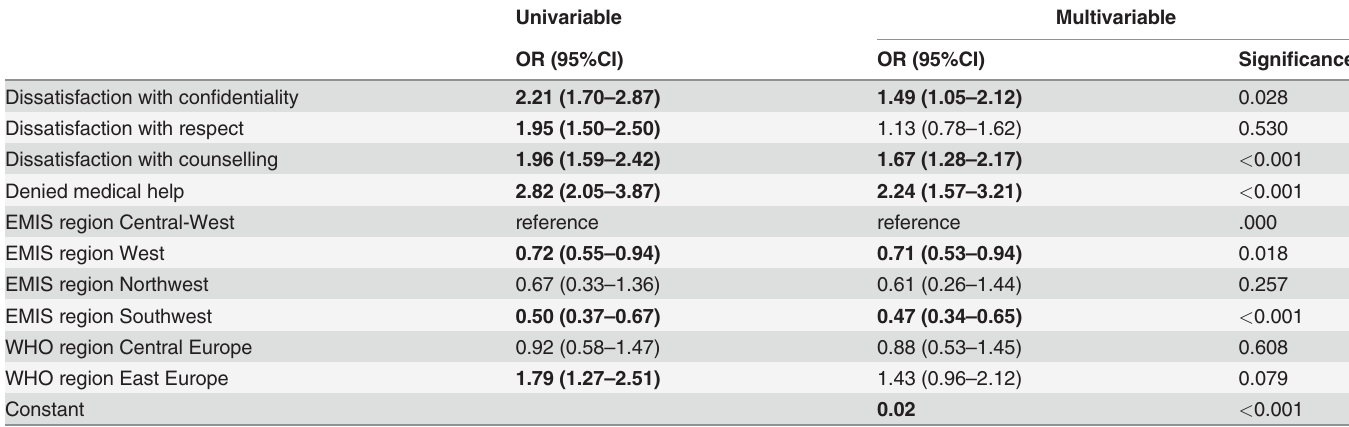
Table 6. Uni- and multivariable analysis of factors associated with “ fear of consequences ” (component2) as reason for not taking